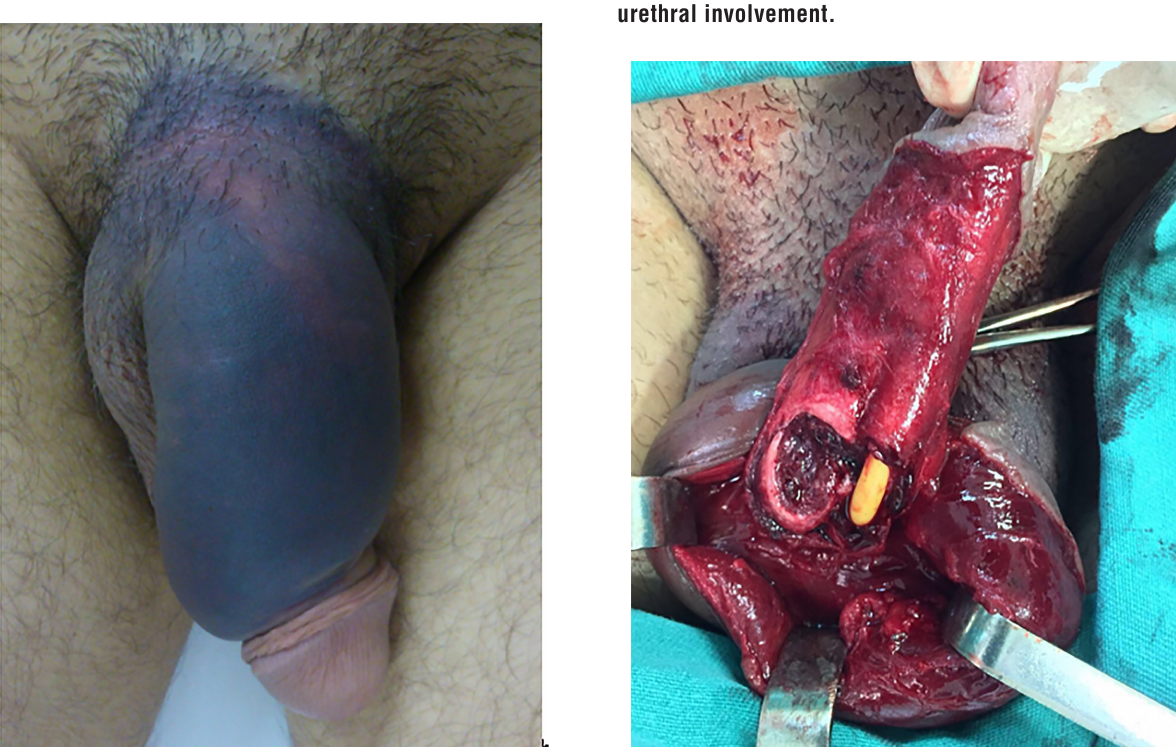
Figure 1 – Penile hematoma in patient presenting penile fracture after rolling over in bed.